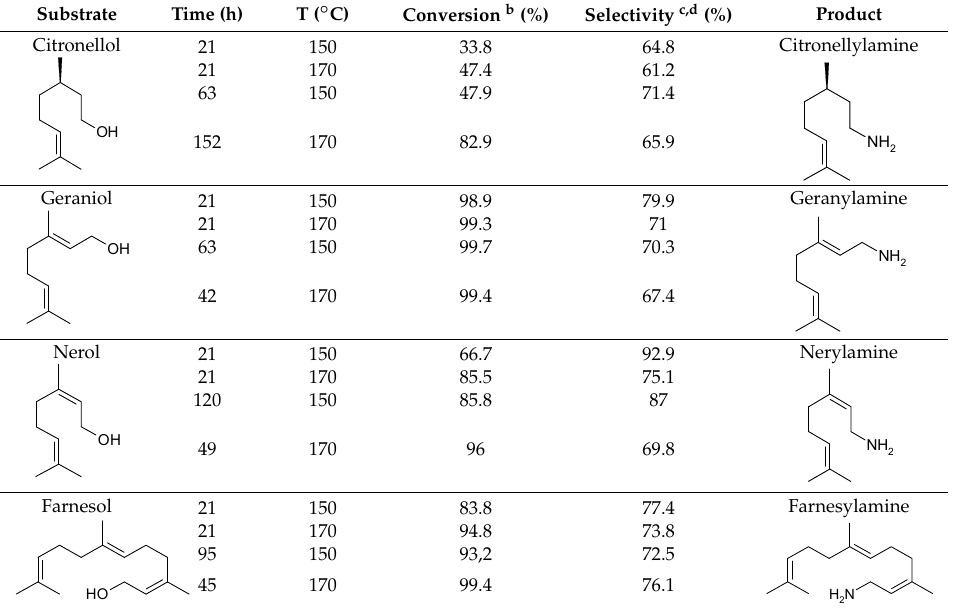
Table 5. Primary terpene alcohol amination with [Ru 3 (CO) 12 ]/L9 a . Adapted from [125]. Substrate